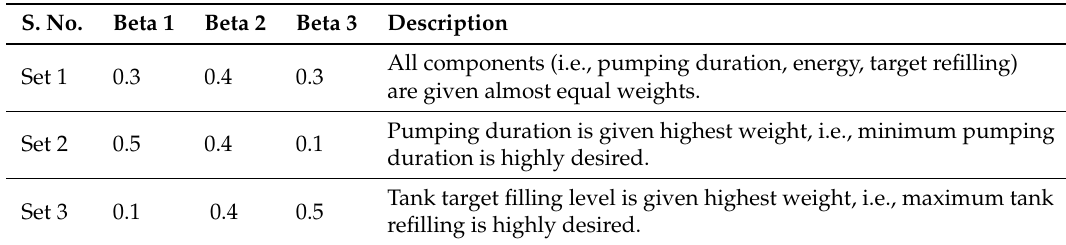
Table 4. Beta values set for testing optimization function.